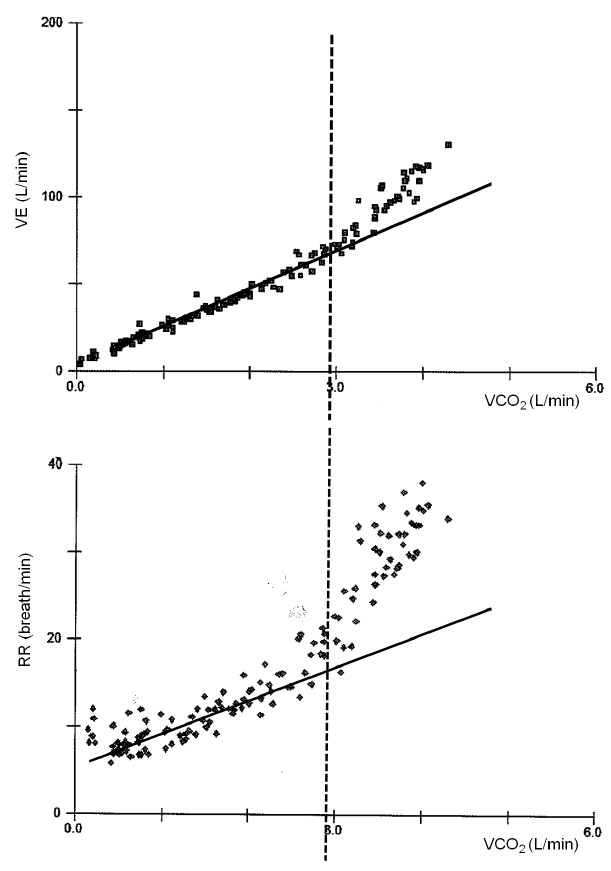
Figure 1. VE vs. VCO 2 relationship in a patient. The relationship is linear up to the respiratory compensation point (end of the isocapnic buffering period) (Upper panel). RR vs. VCO2 relationship. The relationship is calculated as for VE vs. VCO 2 (Lower